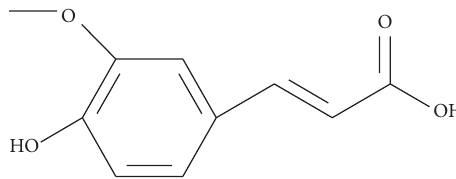
Figure 1: Chemical structure of ferulic acid